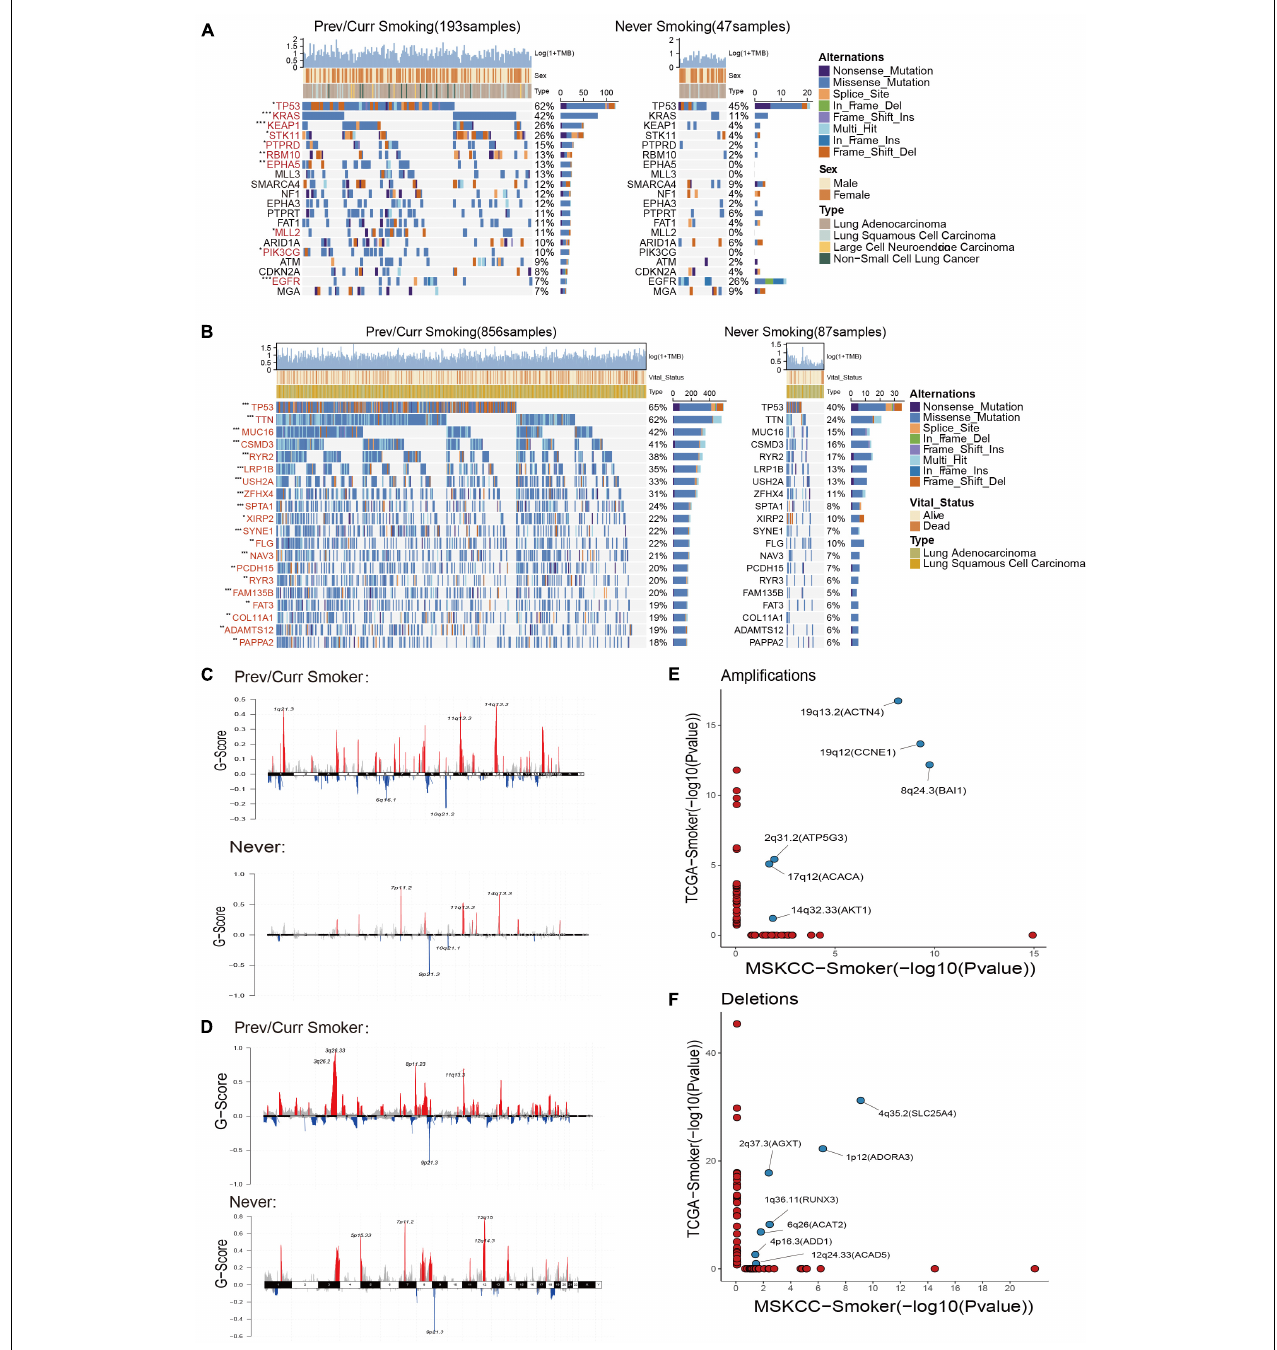
FIGURE 3 | Mutation landscape and copy number variation in different smoking status. (A) Top 20 significantly mutated genes in the immunotherapy cohort of MSKCC database. The mutation landscape was divided into two groups according to smoking status, and genes were ranked by mutation frequencies. The sample type, sex, and TMB score are annotated in order in the top panel. The genes marked in red indicate that their mutation frequency is significantly different between the two groups in Fisher’s exact test ( p < 0.05). (B) Top 20 significantly mutated genes in TCGA Pan-Lung Cancer. The mutation panorama was divided into two groups according to smoking status, and genes were ranked by mutation frequencies. The sample type, vital status, and TMB score are annotated in order in the top panel. The genes marked in red indicate that their mutation frequency is significantly different between the two groups in Fisher’s exact test ( p < 0.05). (C,D) Maftools was used to visualize the copy number alteration (CNV) analysis based on GISTIC2.0 of the MSKCC cohort (C) and TCGA Pan-Lung Cancer cohort (D) under different smoking status. (E,F) The lollipop graph shows the significantly amplified (E) or deleted (F) sites in the smoking group in the MSKCC discovery cohort and the TCGA verification cohort and the main genes encoded by the chromosomal sites. The marked site in the middle is the intersection of the two databases. (A,B) * p < 0.05; ** p < 0.01; *** p < 0.001; **** p < 0.0001; ns, not significant.